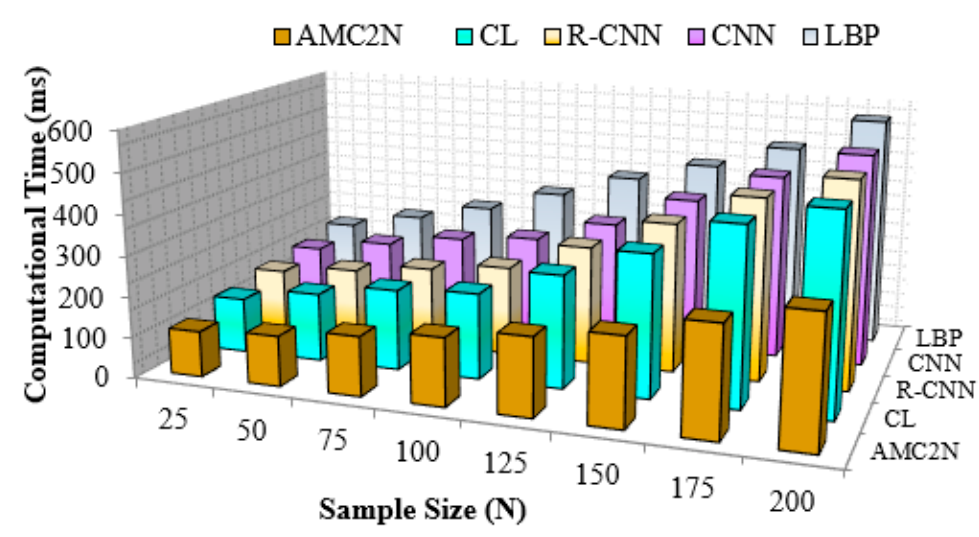
Figure 19. Computation time comparison between AMC2N, convolutional neural network (CNN), Robust-CNN (R-CNN), curriculum learning (CL), and Local Binary Pattern (LBP).